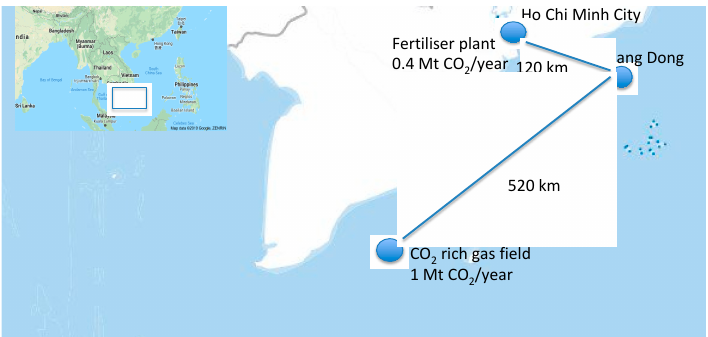
Figure 8. Location of the Rang Dong Field relative to the CO 2 sources. Based on the map in Reference [26].